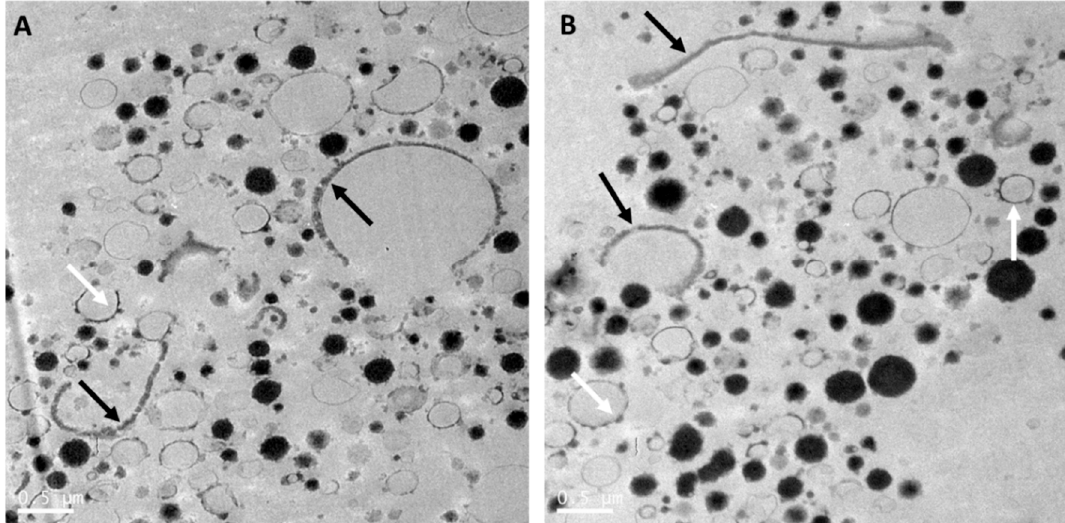
Figure 2. Transmission electron microscopy images ( A and B ) of reconstituted whole goat milk powder (Dairy Goat Co-operative, Hamilton, New Zealand) processed using the same method as in Gallier et al. [5]. Black arrows point at the MFGM surrounding fat globules ( A ) or as fragments in the serum phase ( A and B ). White arrows point at fat globules with adsorbed small casein micelles ( A and B ). Scale bar = 0.5 µm.